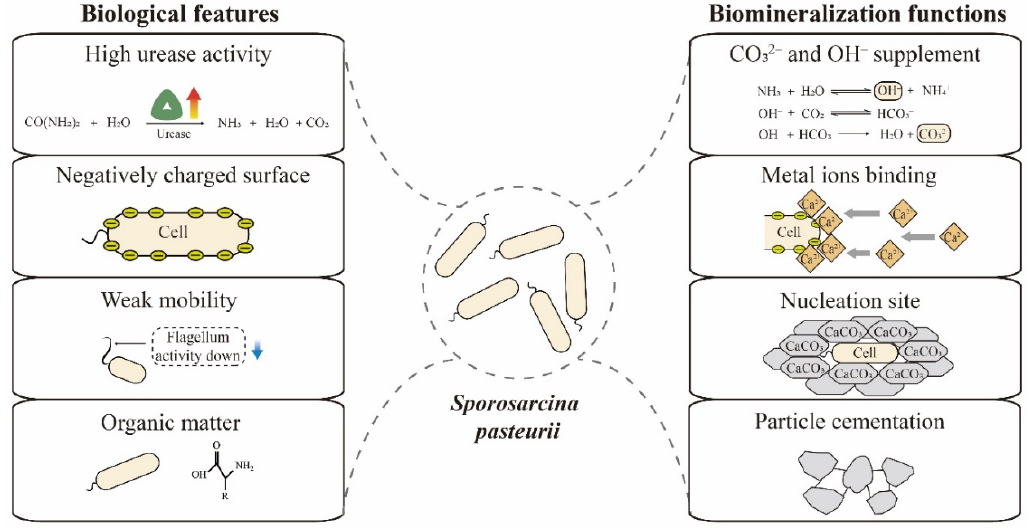
Figure 2. Relevant biological features and biomineralization functions of S. pasteurii cells.